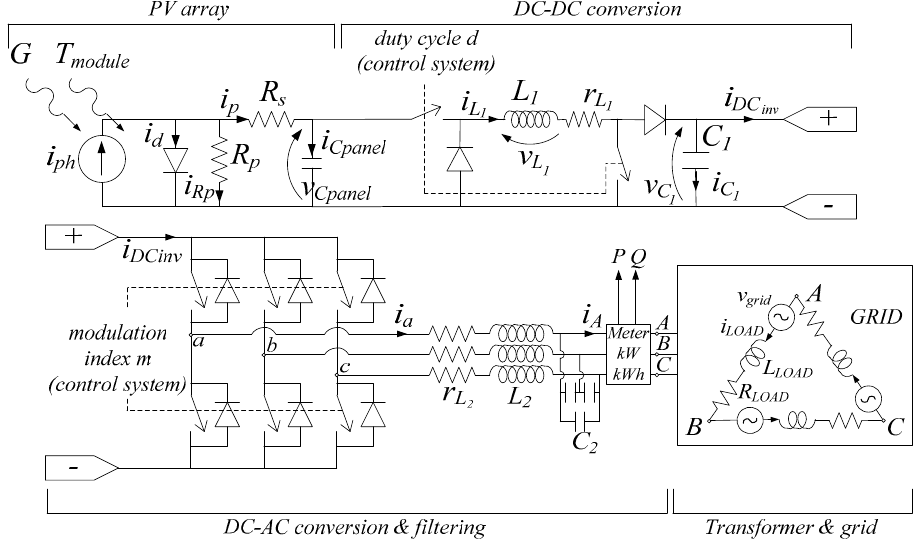
Figure 5. Block diagram of a PV system with multi-stage conversion system.